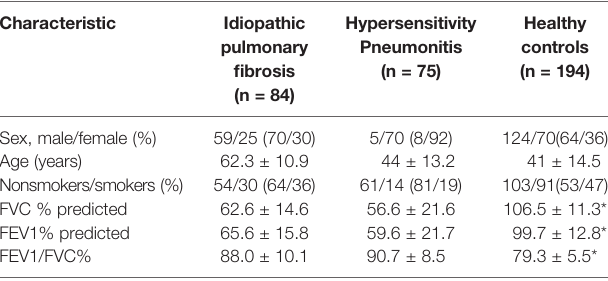
TABLE 1 | Demographics and clinical characteristics of the study